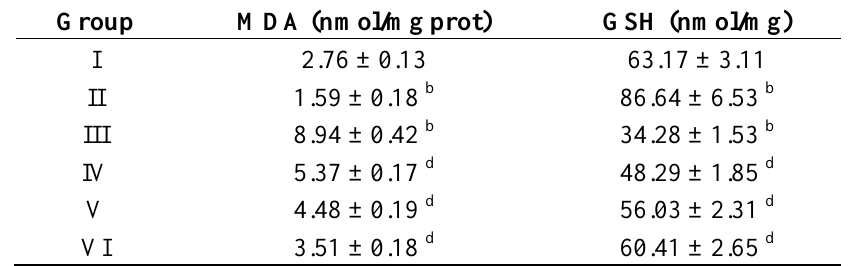
Table 6. Effect of tea polyphenol on liver malondialdehyde (MDA) and glutathione